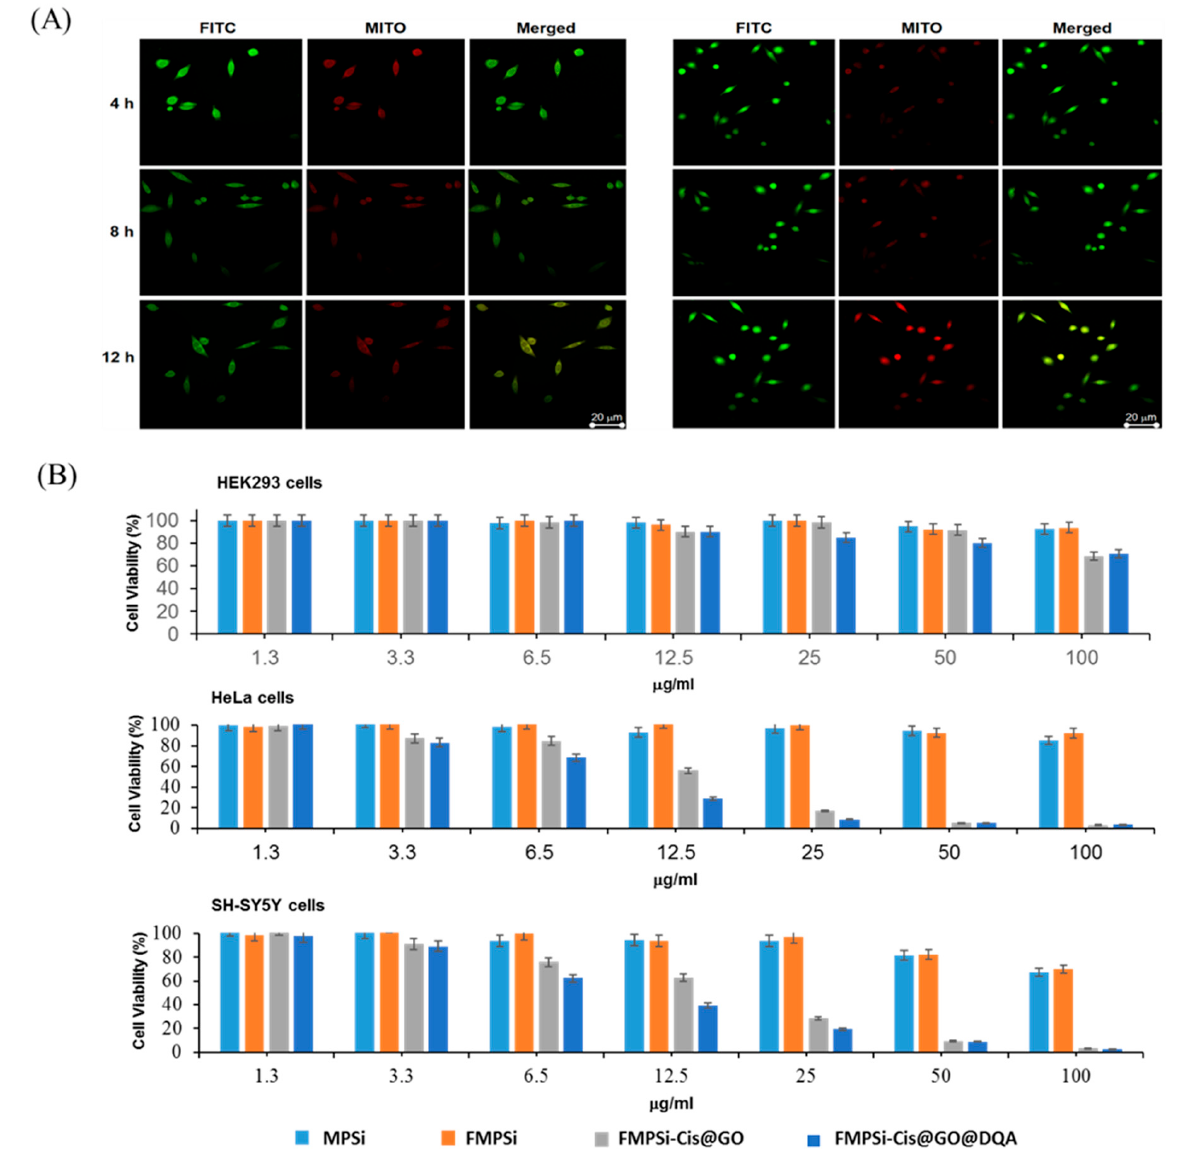
Figure 3. Cellular uptake and cytotoxicity studies: ( A ) Representative confocal microscopy image of HeLa cells after treating with FMPSi-Cis@GO ( left ) and FMPSi-Cis@GO@DQA ( right ) at 4 h, 8 h, and 12 h incubation; ( B ) Cell viability profile of HeLa, SH-S5Y5, and HEK293 cells treated with different concentrations of as-prepared NPs for 48 h. Data are represented as the mean ± SD ( n =